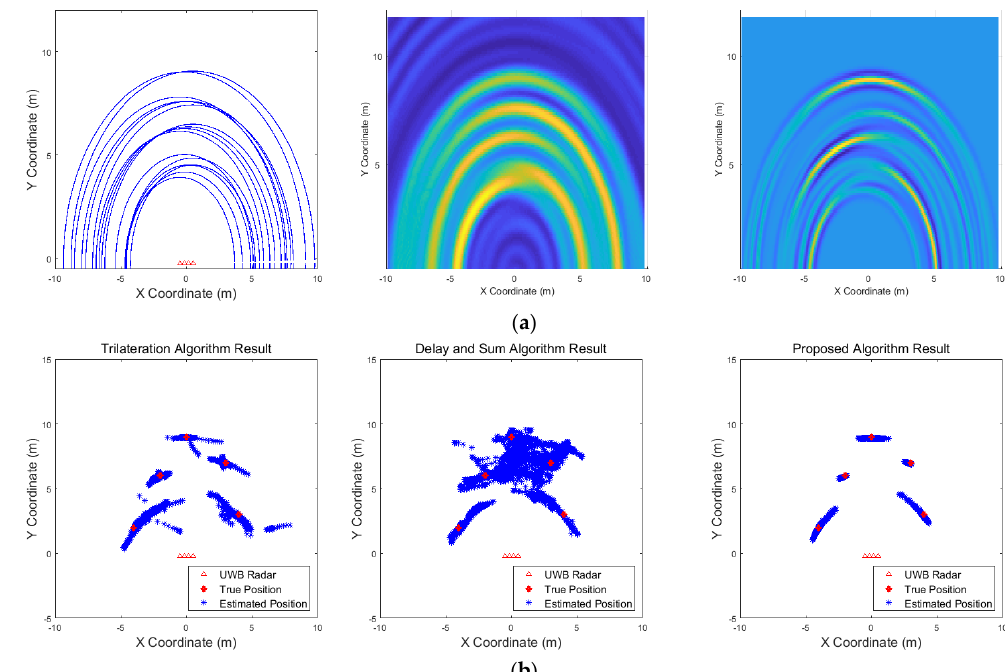
Figure 11. Simulation results when five targets stand (Scenario 3): ( a ) instantaneous results of position estimation step according to the positioning algorithm; ( b ) results of the radar system for the entire simulation.